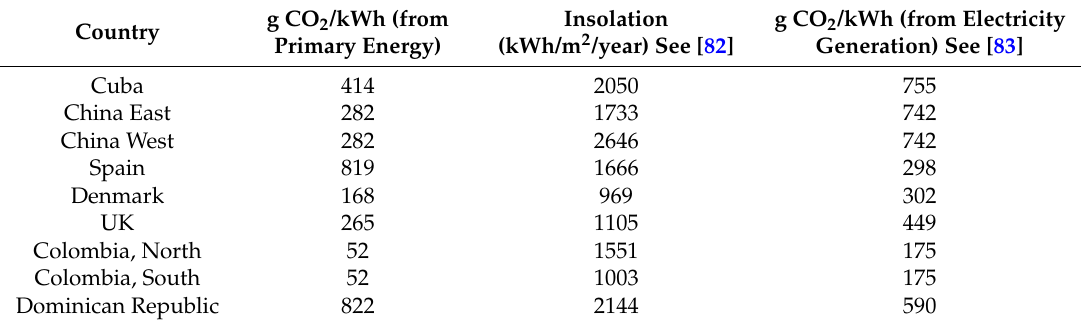
Table 4. CO 2 per kWh of produced primary energy (electricity) and insolation levels in selected countries,